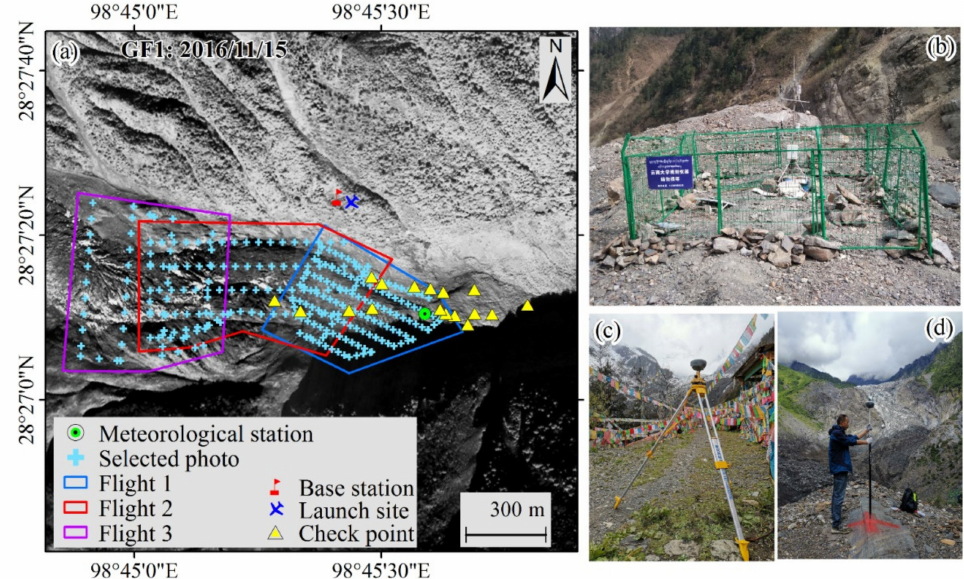
Figure 2. ( a ) Overview of the study area, UAV flights, selected photos and checkpoint. ( b ) Meteoro- logical station. ( c ) The UBase station. ( d ) RTK-GPS measurements along the lateral moraine. The projection of left panel is WGS84/UTM ZONE